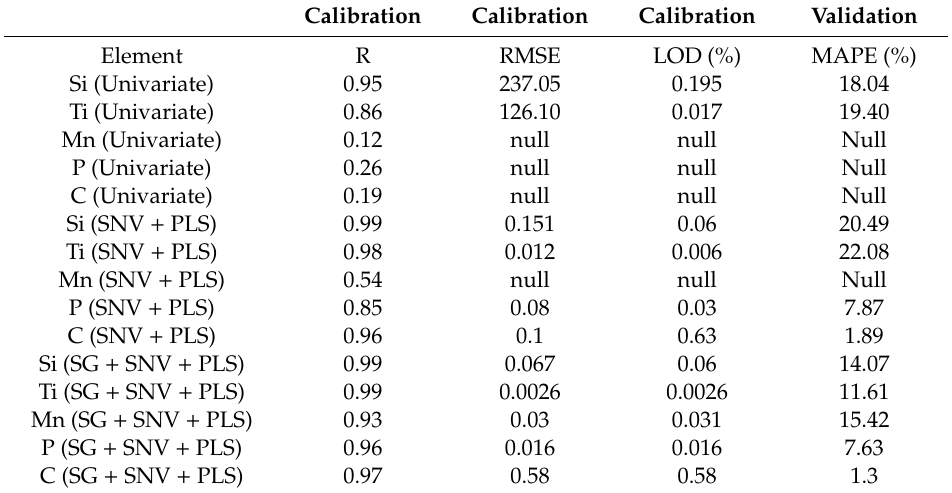
Figure 8. Calibration ( a , c , e , g , i ) and validation ( b , d , f , h , j ) curves for the elements C, Mn, P, Si, and Ti constructed by partial least square (PLS) treatment of data versus XRF certified concentrations. Table 1. Results achieved by applying univariate, SNV + PLS and SNV + SG + PLS models. Calibration